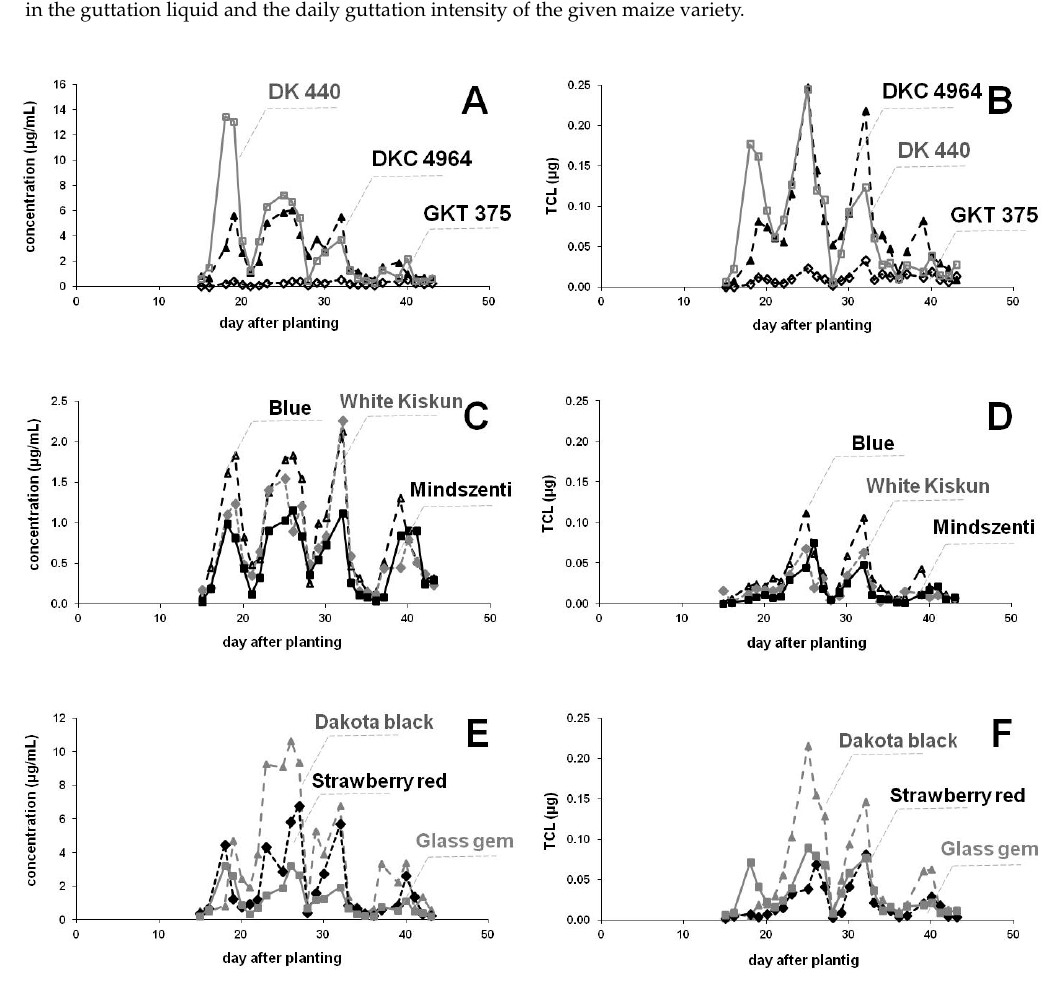
Table 1. Maize seeds used for comparison of varieties.